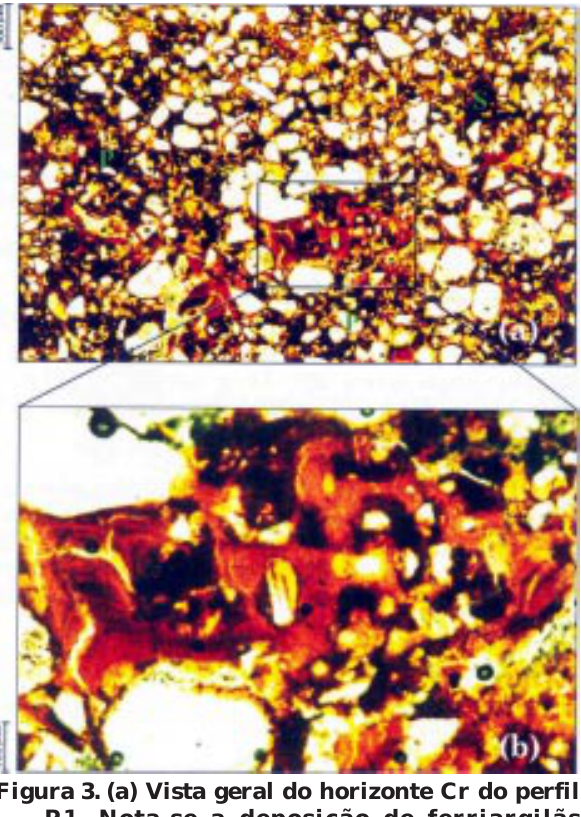
Figura 3. (a) Vista geral do horizonte Cr do perfil P1. Nota-se a deposição de ferriargilãs na porosidade gerada entre os fragmentos de saprolito (P) e o solo (S). Luz nomal - 2,5x. (b) Detalhes do ferriargilã da figura 3a. A incorporação de grãos de quartzo muito fino no preenchimento sugere sua movimentação à curta distância, juntamente com a argiluviação. Luz normal - 10x.